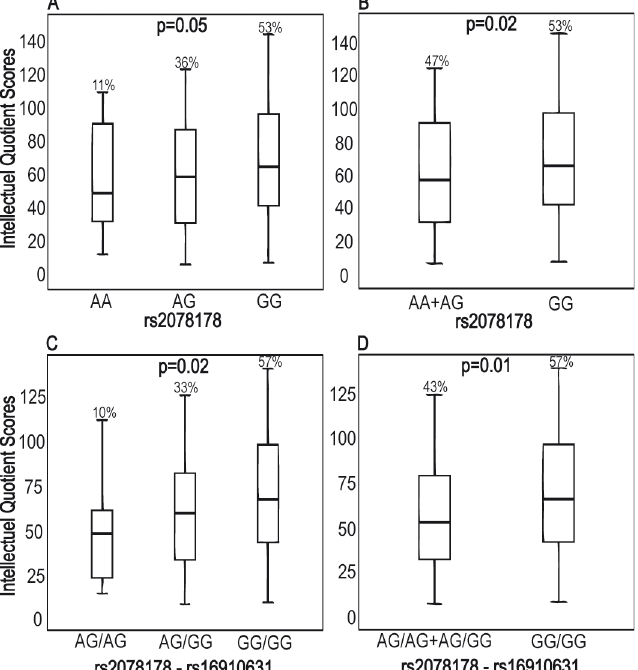
Fig 1. CLEC7A genotype and haplotype are associated with intellectual quotient (IQ) scores in ASD. A and B Kruskall-Wallis nonparametric testing show associations between CLEC7A genotypes (p = 0.05) / haplotypes (p = 0.02) and IQ scores. Patients bearing the CLEC7A rs 2078178 GG or the CLEC7A rs 2078178/ rs 16910631 G-G/G-G genotypes have higher IQ scores as compared to other patients. C and D Mann-Whitney nonparametric testing also showed significant associations for similar comparisons (respectively p = 0.02 and p = 0.01). The dark line inside the boxes represents the median value for each group. Boxes include the 25th and 75th quartiles; bars outside the boxes represent the maximal and minimal